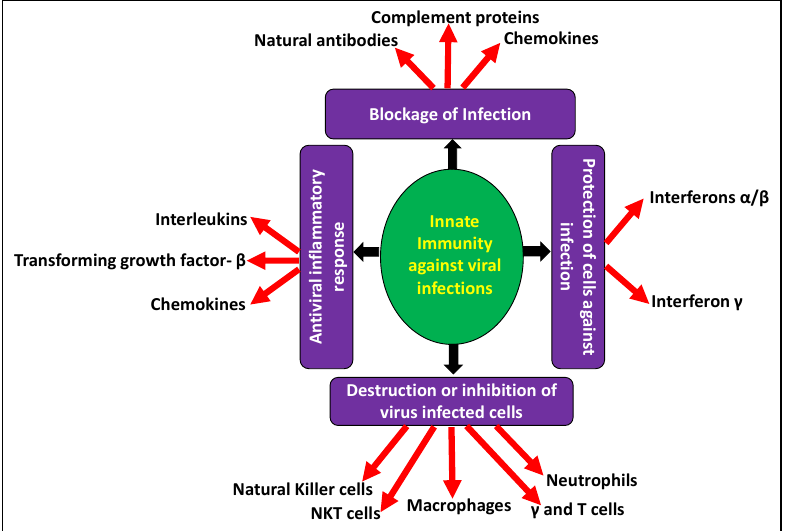
Figure 3. Schematic representation of immunity against viral pathogens.